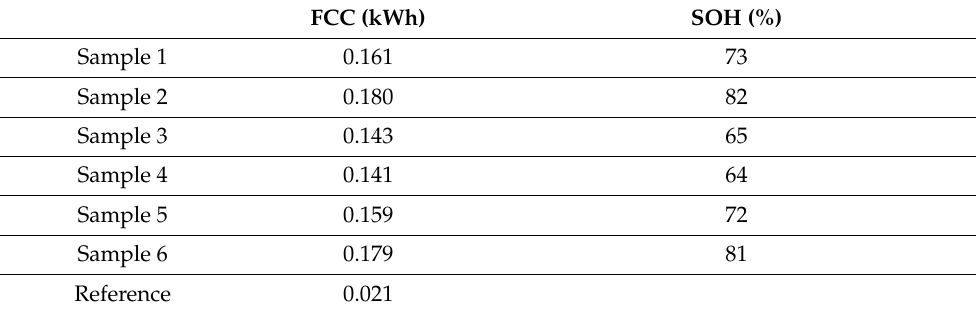
Table 1. FCC and calculated SOH values for the module